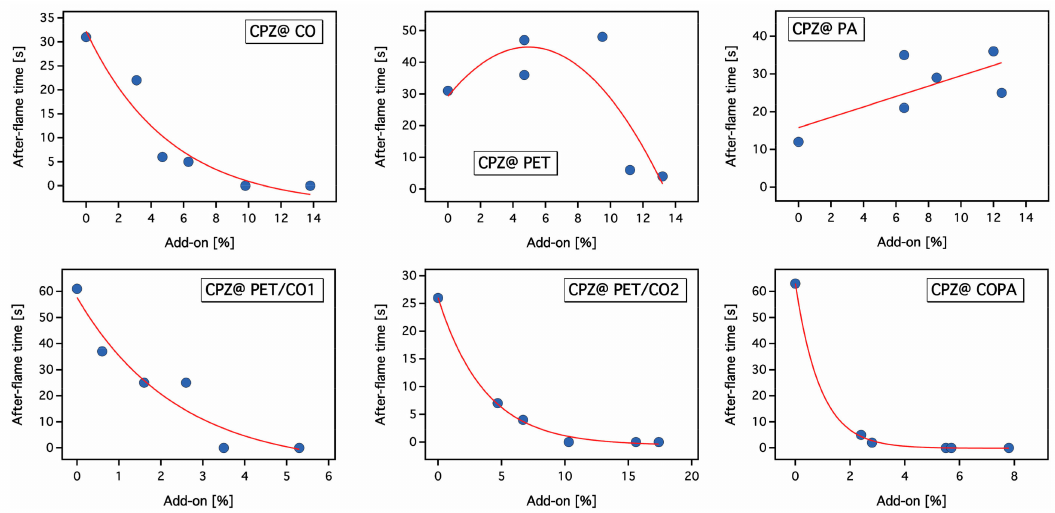
Figure 7. Evolution of after-flame time in the flame test according to DIN EN ISO 15,025 after one washing cycle in dependency of the gravimetrically measured add-on.